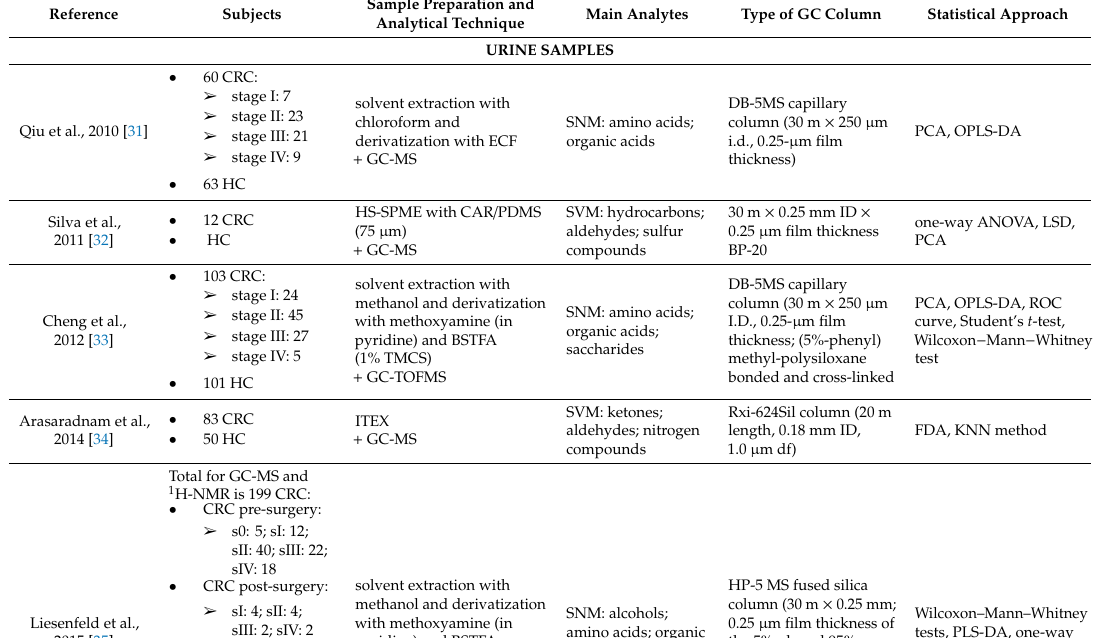
Table 1. Table summarizing all 21 studies regarding investigation of biomarkers of CRC in urine, feces, and breath